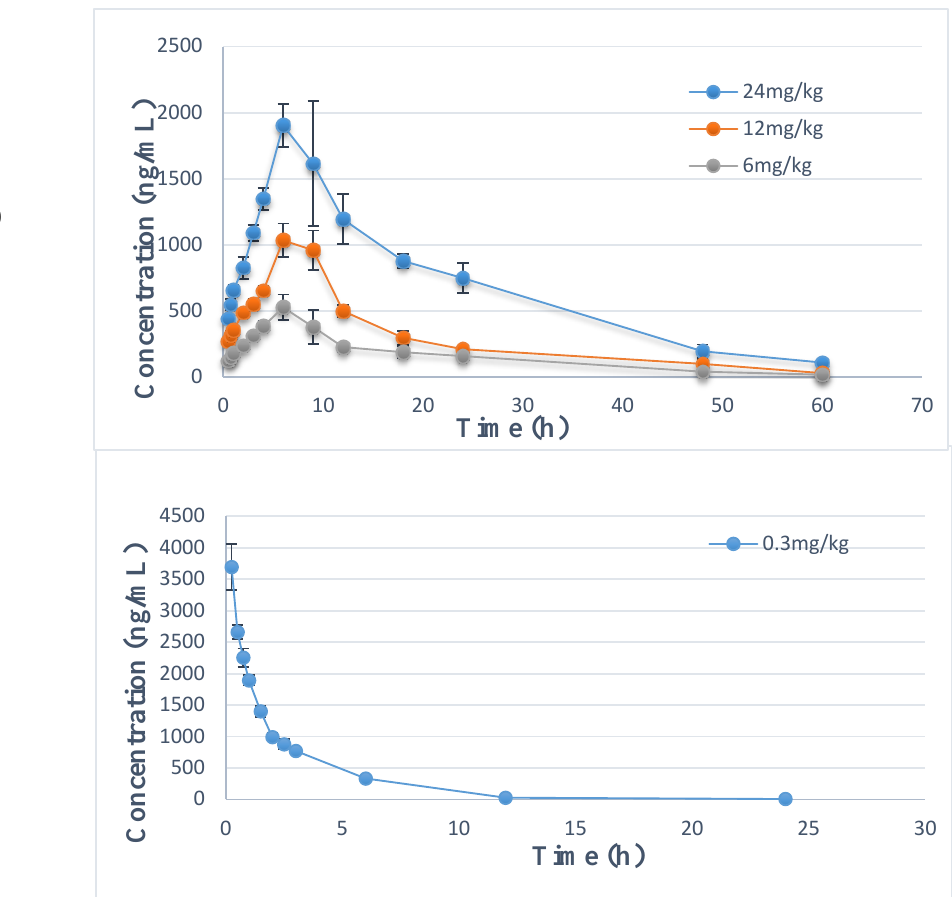
Figure 3. Mean plasma concentration–time profiles of RPDQ after intragastric administration ( A ) and intravenous administration ( B ) in rats.